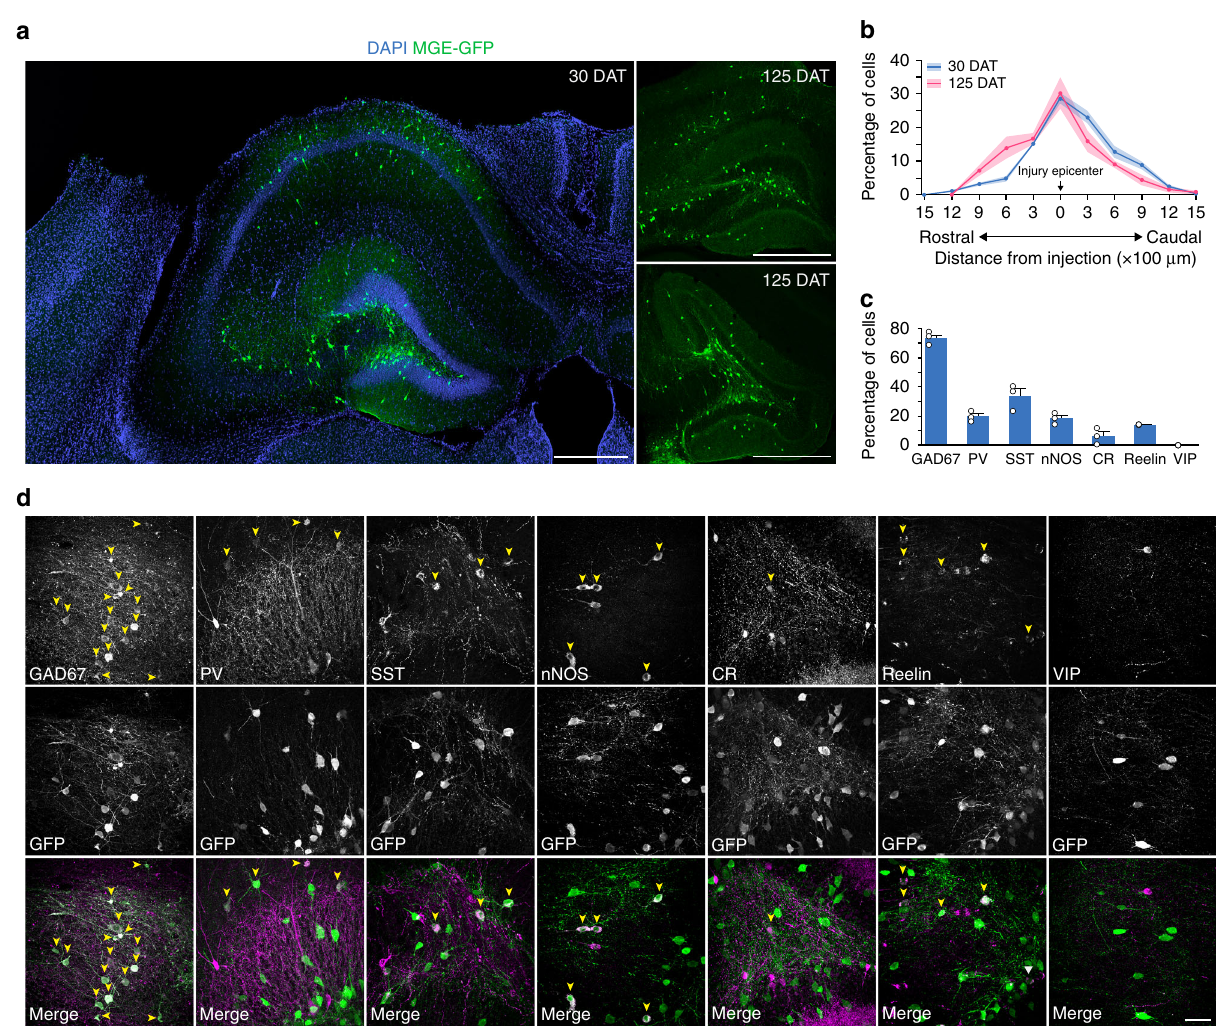
Fig. 1 Transplanted MGE cells migrate and express markers of inhibitory neurons. a Hippocampus of CCI-injured recipients 30 DAT and 125 DAT labeled for DAPI (blue) and GFP + transplanted neurons (green). MGE cells dispersed after grafting into recipient mice despite extensive hippocampal damage resulting from the contusion injury. b Distribution of transplanted MGE cells 30 DAT (blue, n = 3 TBI mice) and 125 DAT (pink, n = 3 TBI mice). F (1,44) = 2.1 × 10 − 13 ; P = 0.99, two-way repeated measures ANOVA. c Quanti fi cation of marker expression of GFP-labeled cells in brain injured animals at 30 DAT ( n = 3 mice per marker). CR calretinin, nNOS neuronal nitric oxide synthase, PV parvalbumin, SST somatostatin, VIP vasoactive intestinal peptide. d Representative confocal images in hippocampus (30 DAT) of staining for GFP (green) and molecular markers of inhibitory interneurons (magenta). Arrowheads, co-labeled cells; error bars, s.e.m.; scale bars, 500 μ m ( a ) and 50 μ m ( d ). Source data are provided as a Source Data